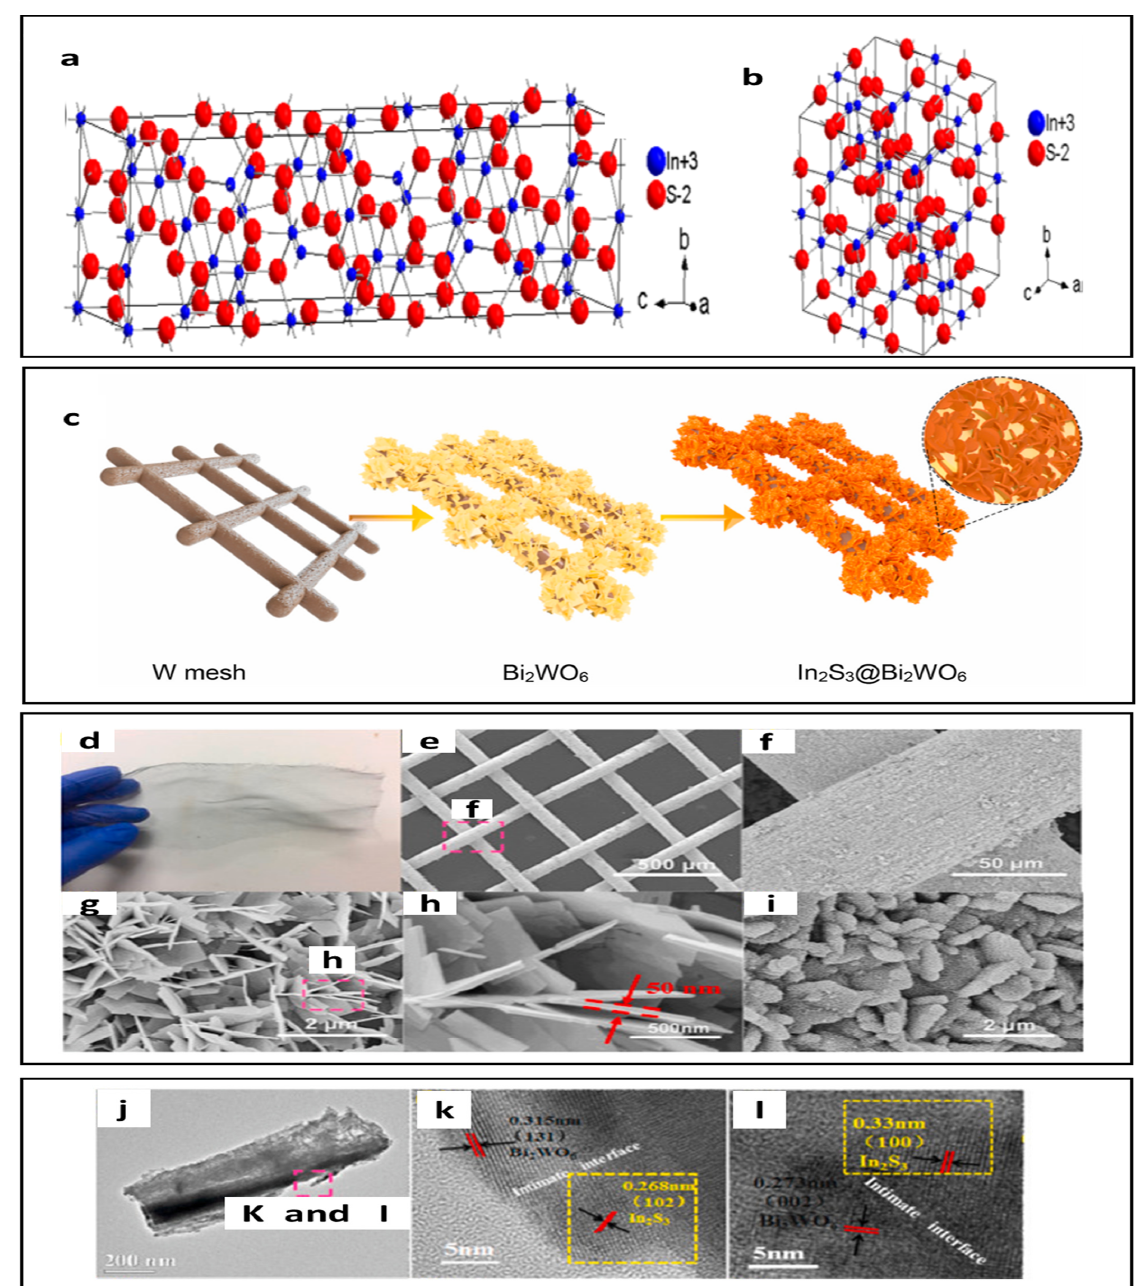
Figure 7. Crystal structures of β -In 2 S 3 : ( a ) tetragonal phase; ( b ) cubic phase (reprinted with permis- sion from [181] Copyright 2018 American Chemical Society). ( c ) the schematic illustration of syn- thesis In 2 S 3 @Bi 2 WO 6 crystals on W mesh; ( d ) digital picture of pristine W mesh; ( e – i ) the SEM images of ( e ) Bi 2 WO 6 /W mesh (low-magnification); ( f ) enlarged SEM image of the part marked in(e); ( g , h ) with increased resolution of the SEM images of Bi 2 WO 6 nanosheets; ( i ) SEM image of In 2 S 3 nanoflakes anchored Bi 2 WO 6 ; ( j ) TEM images of In 2 S 3 @Bi 2 WO 6 ( k , l ) the HRTEM images of marked part in ( j ) (reprinted with permission, copyright Elsevier (2022)) [186].